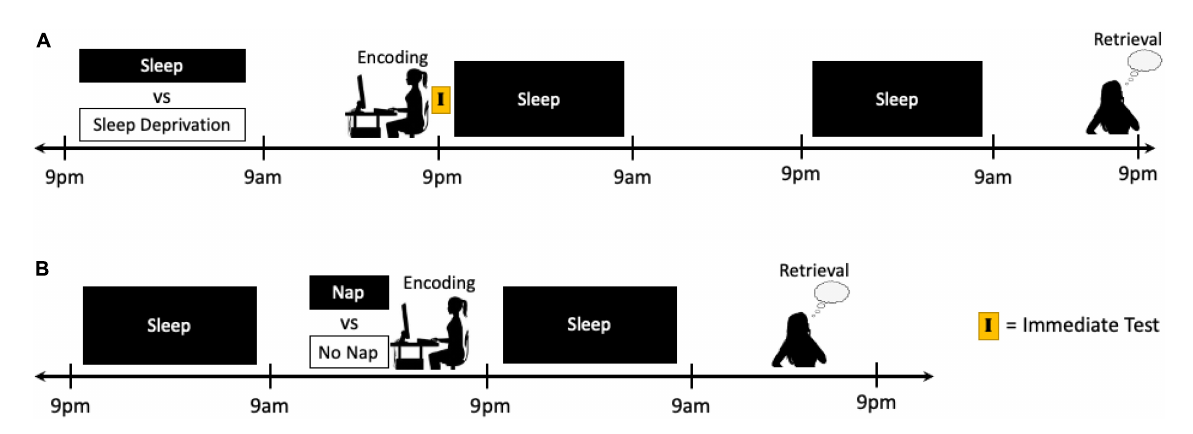
FIGURE3 Schematics of two potential study protocols designed to target the effects of sleep manipulation on the pre-encoding period of emotional memory processing. (A) Following a night of sleep or sleep deprivation, participants can complete an encoding task just prior to the next night of sleep, thus manipulating sleep prior to encoding while allowing both groups to sleep during the early consolidation phase and be rested again prior to final retrieval. (B) Typically rested participants can remain awake or be given a nap opportunity prior to an encoding task, and then all participants can be given a normal night of sleep prior to testing the next day. The primary challenge in targeting the pre-encoding phase of memory processing is distinguishing the specific effects of the sleep manipulation on the encoding of information from any lingering effects that the sleep manipulation may have during the early consolidation